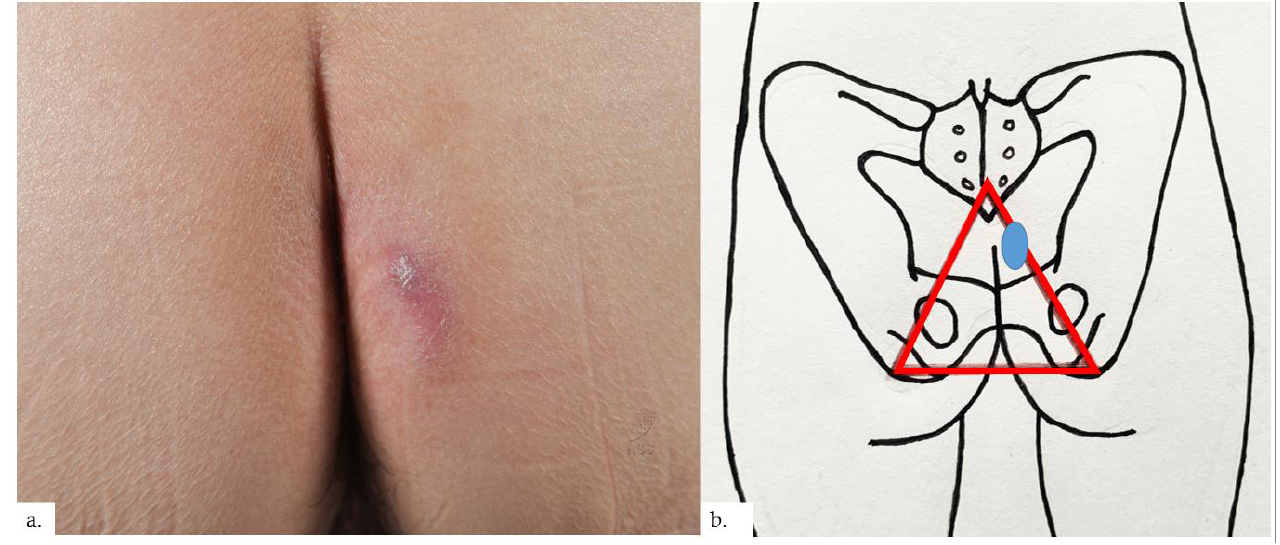
Figure 5. Patient 3. ( a ) There was a unilateral erythematous plaque over the right buttock with scaling and surrounding erythema; ( b ) the plaque (blue oval) was at the right intergluteal fold, within the sitter’s triangle (red triangle).